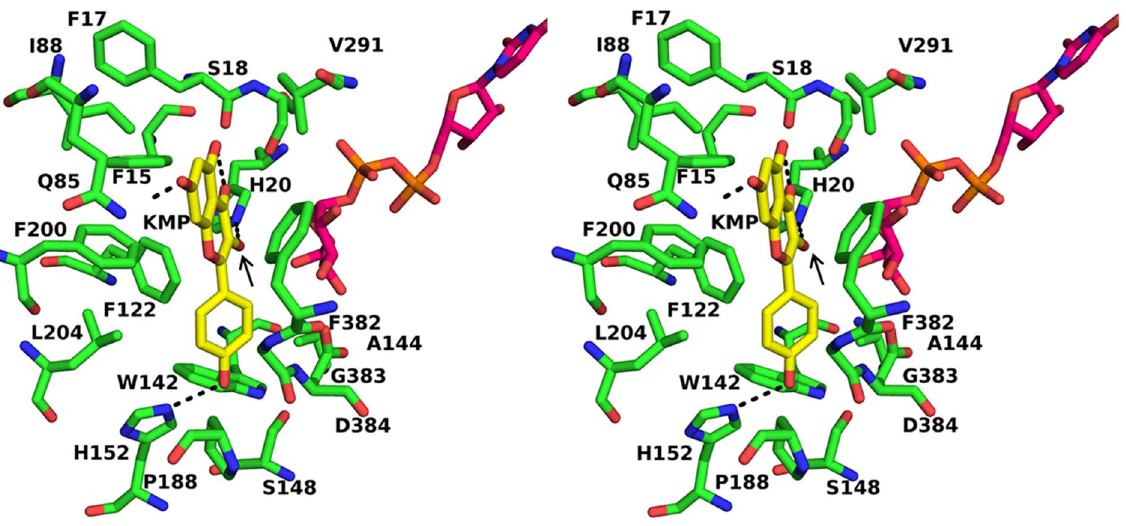
Figure 5. Docked complex of UGT with kaempferol and UDP-glucose. Stereo view of the docked complex of UGT from F. ananassa with kaempferol shown in stick form. The arrow shows the 3-OH group of kaempferol which take part in glycosylation event. UDP-glucose is also shown in stick form.